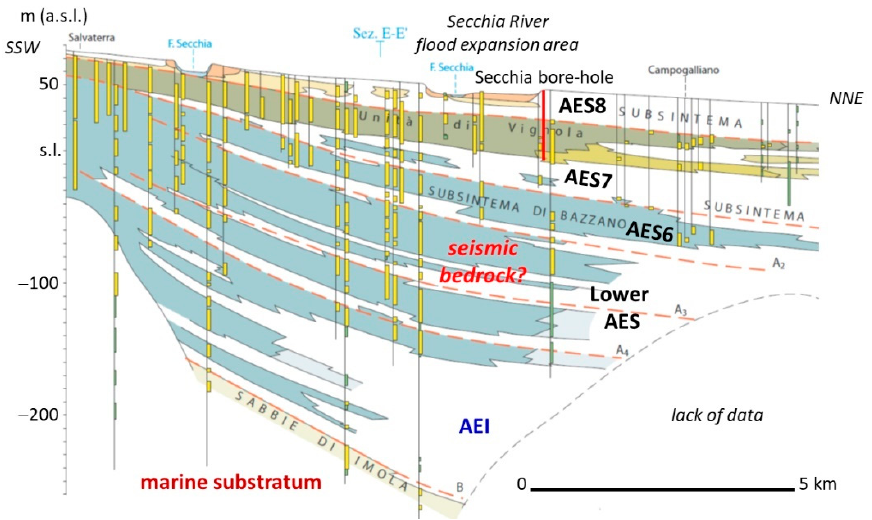
Figure 13. Geological cross-section across the Secchia River alluvial fan (from CARG 1:50,000, sheet n. 201 “Modena”, with modifications).